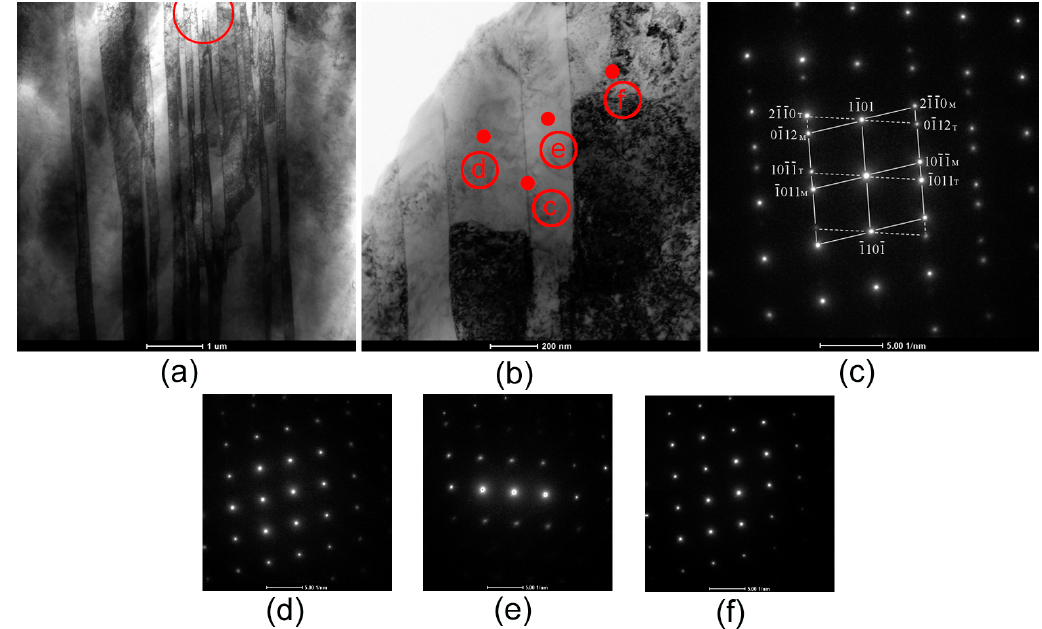
Figure 4. TEM microstructure of CP Ti processed by RD-ECAP for two passes showing { 1011 } twinning: ( a ) micrographs of elongated parallel bands; ( b ) partial enlarged detail of the inner region of the red circle in (a); ( c – f ) the corresponding selected area electron diffractions of the regions indicated in Figure 4b. The zone axis is [ 0111 ].